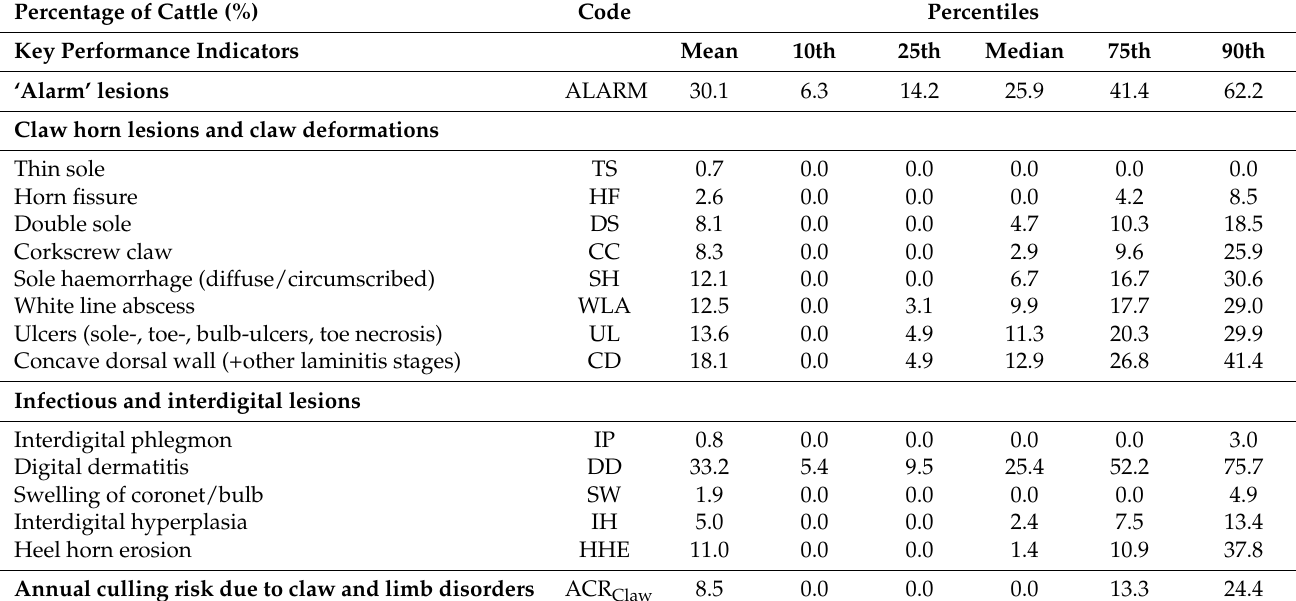
Table 4. Benchmarking claw lesion incidence risk and the annual culling risk due to claw and limb disorders (ACR Claw ) of cattle from 512 Austrian dairy herds for 2020 by classification of the herds arranged into the mean, median and 10th, 25th, 75th and 90th